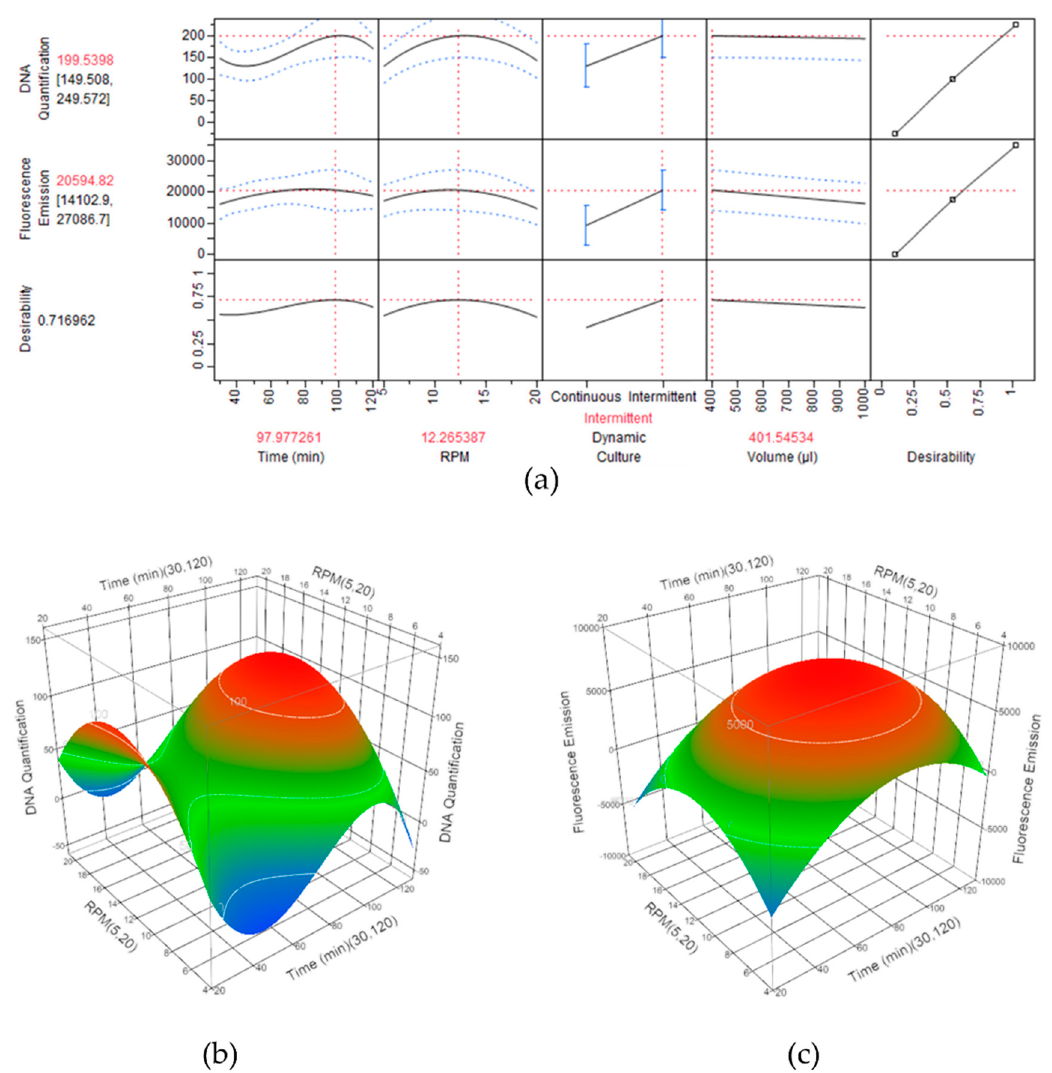
Figure 6. DoE outcome reporting the optimal parameter configuration obtained maximizing the desirability in the statistical software. ( a ) Extraction of the optimal combination by the maximization of the input variables. ( b ) Surface profiles of the DNA quantification and ( c ) of the total metabolic activity, related to the seeding time (min) and the stirring speed (RPM). (red: maximum efficiency; green: medium efficiency; blue: low efficiency).